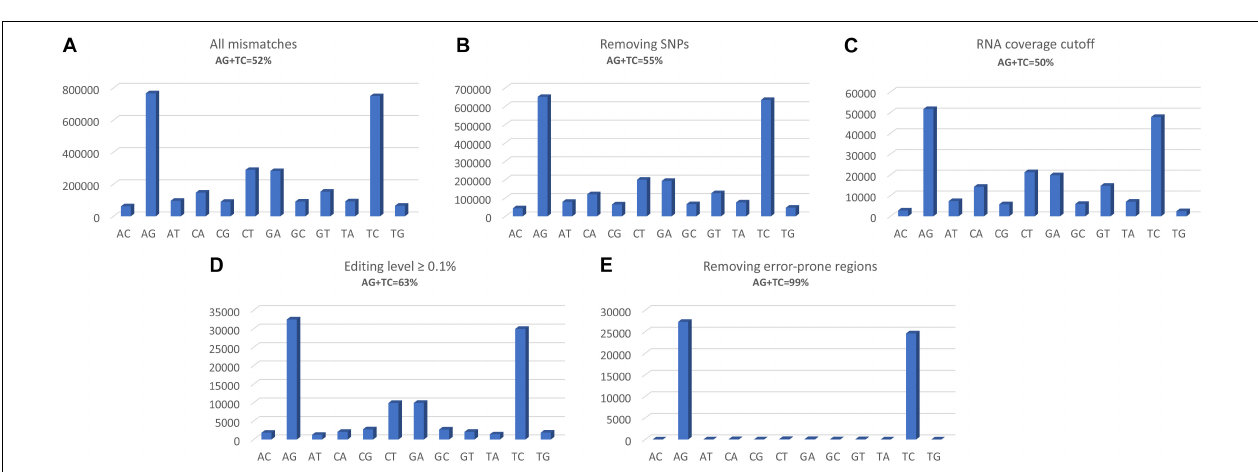
FIGURE 4 | Distributions of RNA variants detected by REDItools obtained following the different filtering steps: (A) all mismatches found following mapping, with a phred quality score of at least 30; (B) selecting only sites supported by at least 10 WGS reads and removing positions in dbSNP; (C) selecting sites covered by at least 10 reads and not falling in homopolymeric stretches longer than five residues or in the first and last six bases of a read; (D) selecting sites with an editing frequency of at least 0.1; (E) excluding sites in mis-mapped reads (by Blat correction) or near splice sites or in genomic regions containing poorly aligned reads.